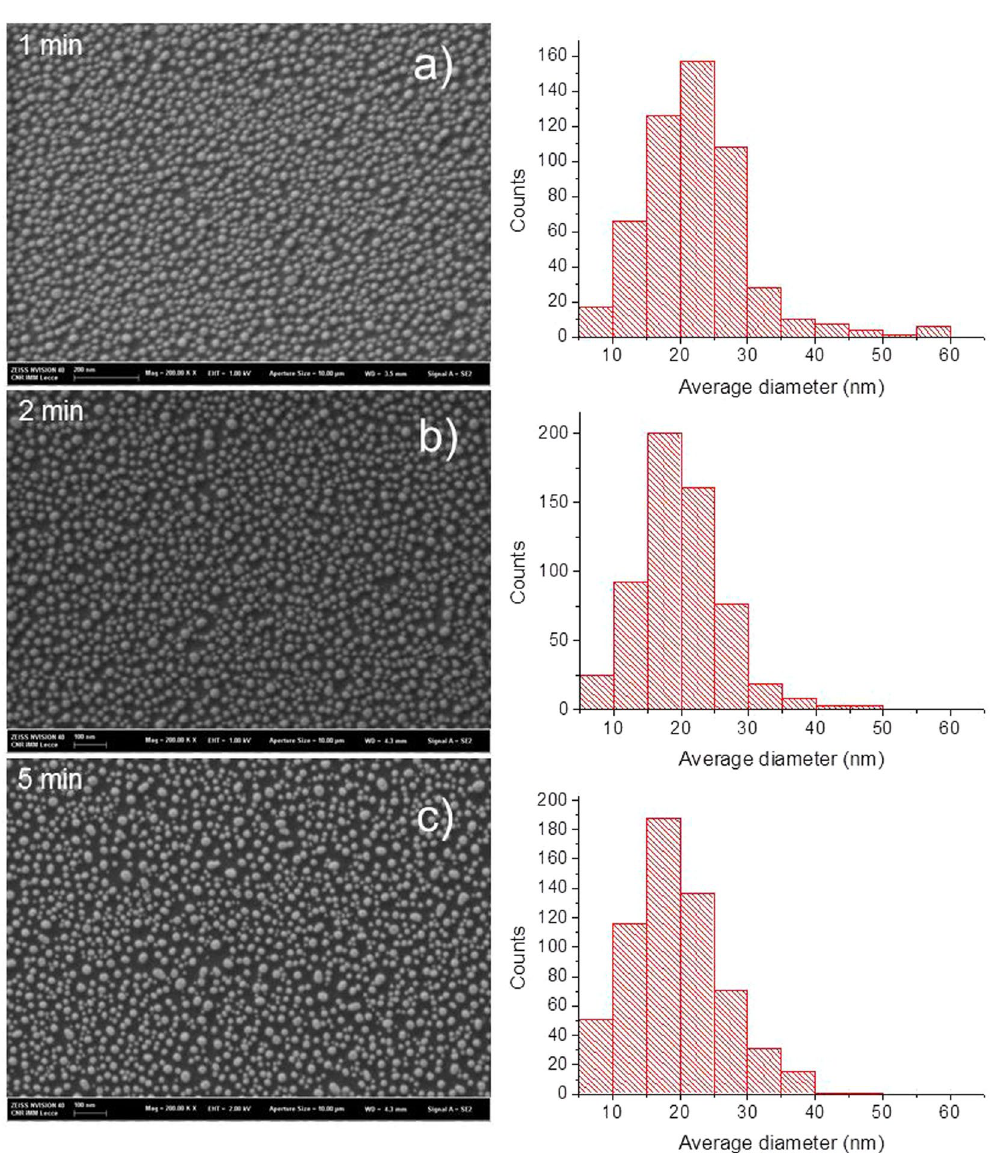
Figure 1. Morphology of the nanostructured gold nanoparticles obtained by SEM after a rapid thermal annealing treatment during ( a ) 1 minute ( b ) 2 minutes ( c ) 5 minutes. Statistical histogram of the nanostructures are reported on the right side.